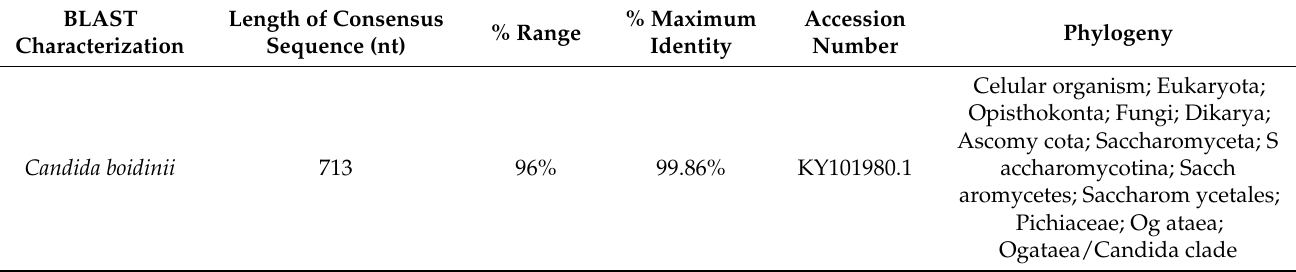
Table 1. BLAST characterization of the rDNA sequence of yeast isolated from the anode plate of MFC.